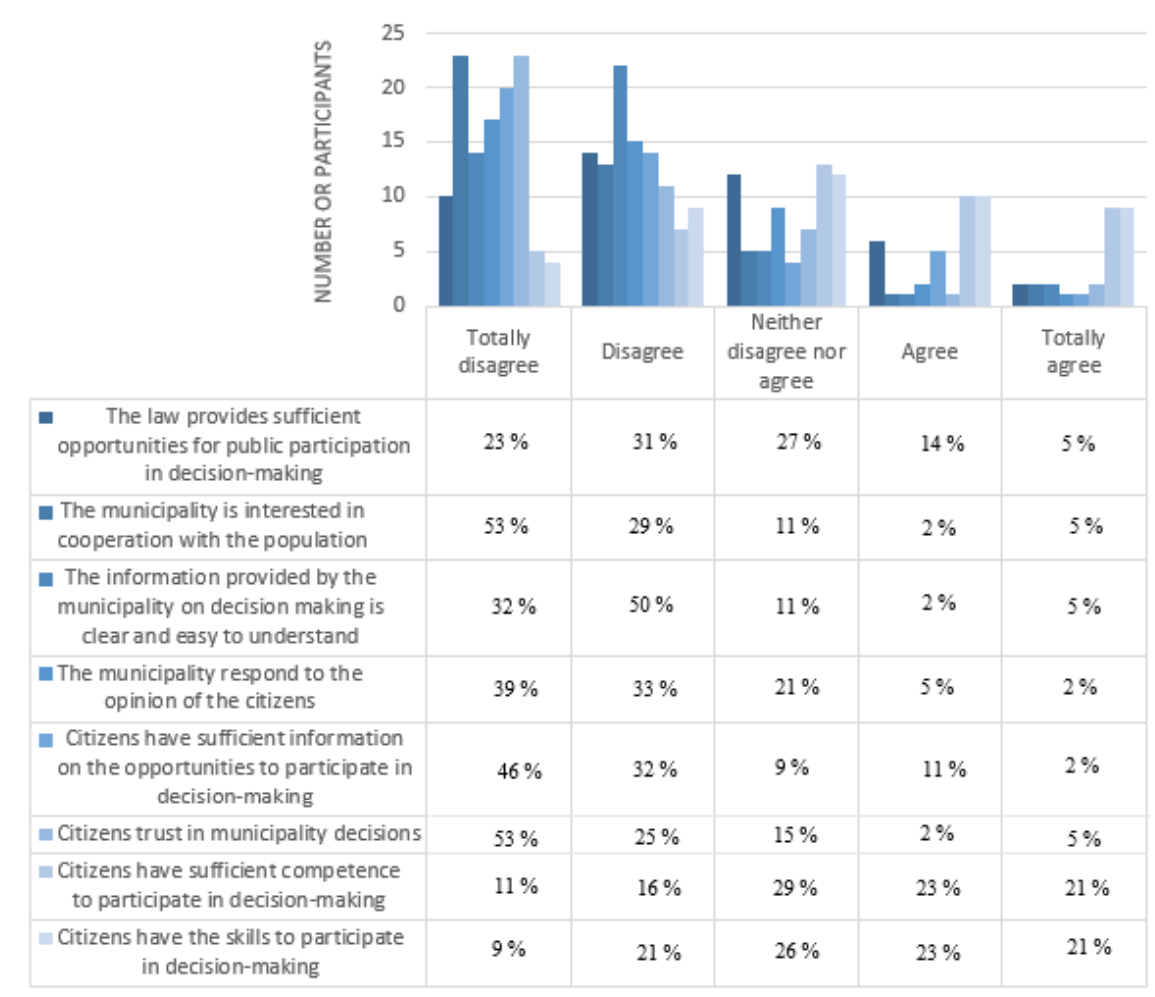
Figure 5. Respondents 'opinion about the citizens' participation in territorial planning document solutions (Survey